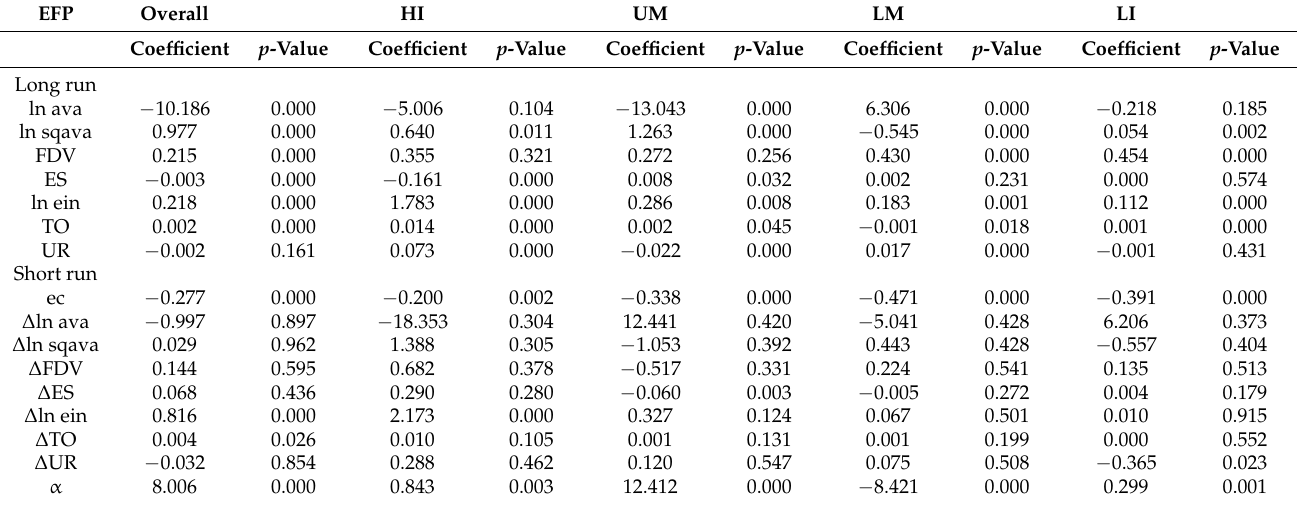
Table 9. The impact of the agriculture sector (ava) on